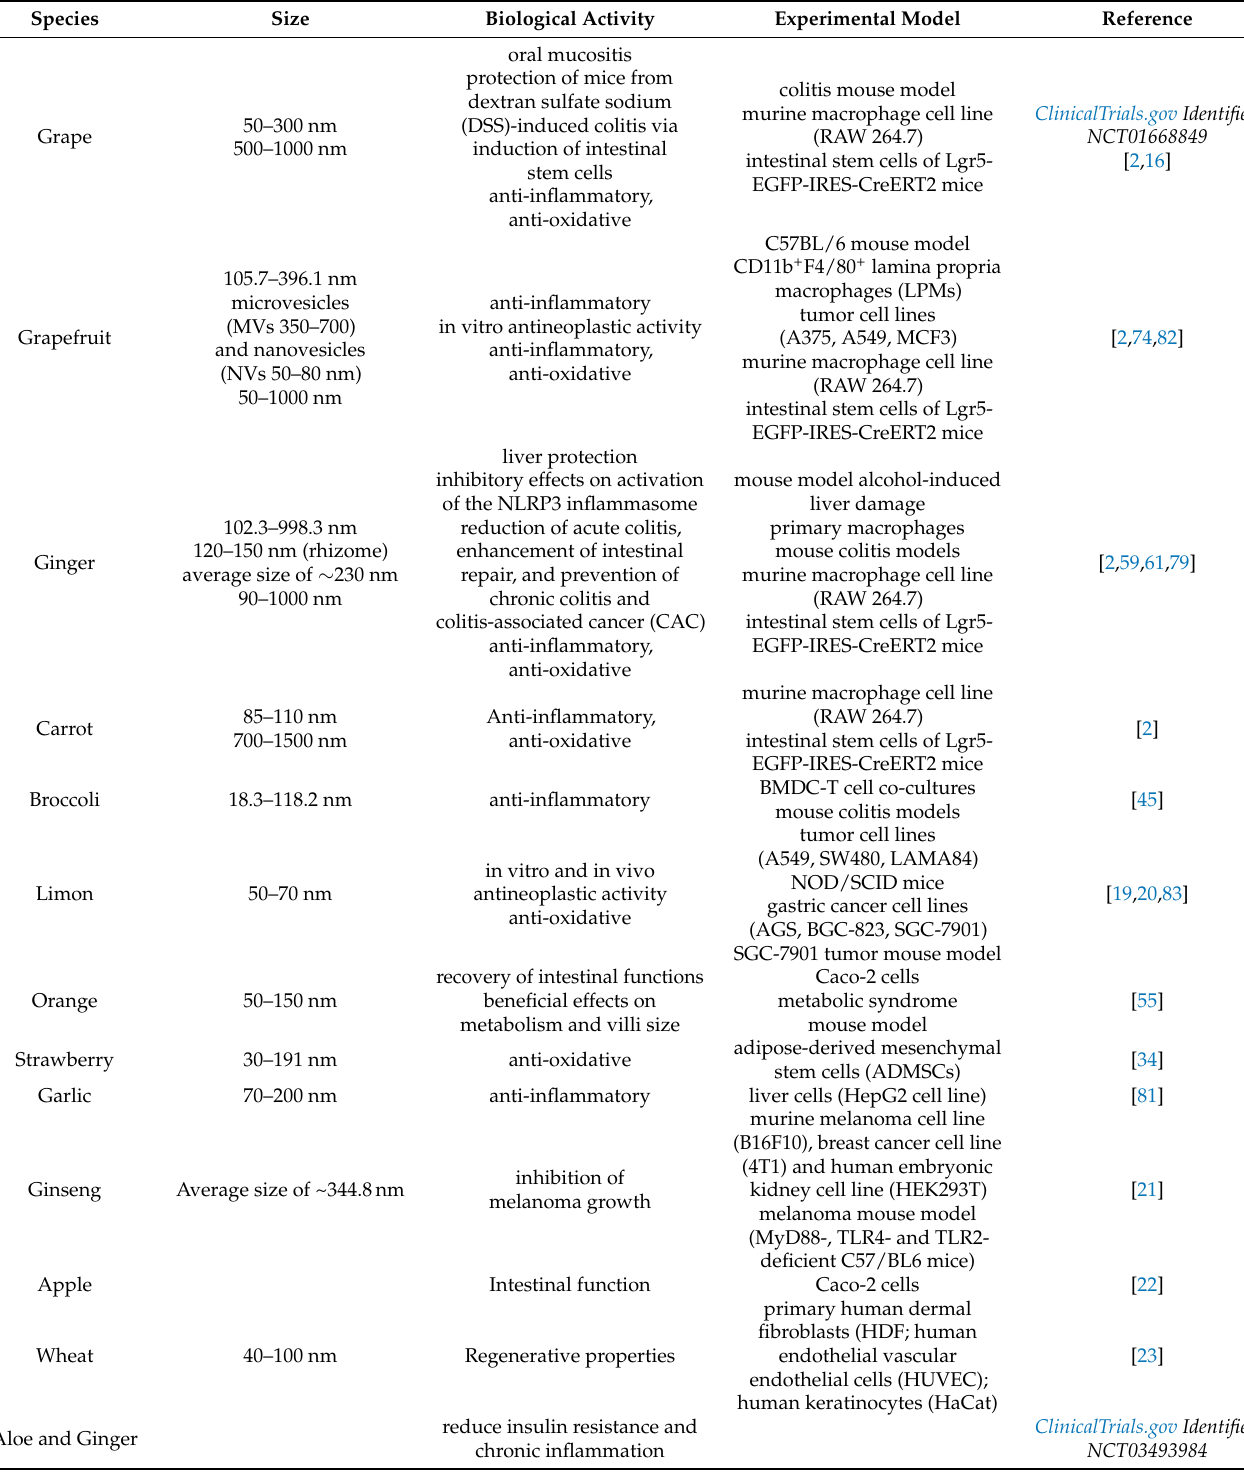
Table 1. Therapeutic effects of natural plant-derived vesicles purified from different fruits and vegetables. The table includes the plant species used as source of PDVs, the PDV size distribution, the biological activity observed, the experimental model employed to study the biological effects of PDVs together with the respective